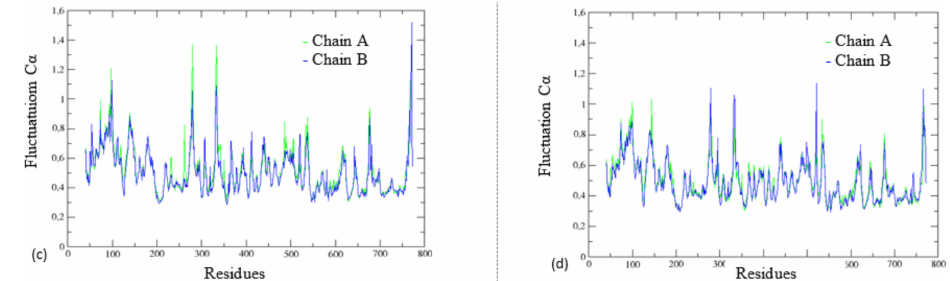
Figure 3. Fluctuation of α -carbon from DPP-4 (PDB: 4A5S [20,21]) at the presence and absence of inhibitor in the chains, with overlap of the two DPP-4 chains for the following systems: ( a ) dimer with inhibitor only in the chain A; ( b ) dimer with inhibitor only in the chain B; ( c ) dimer with inhibitor in both chains; ( d ) dimer without inhibitor.